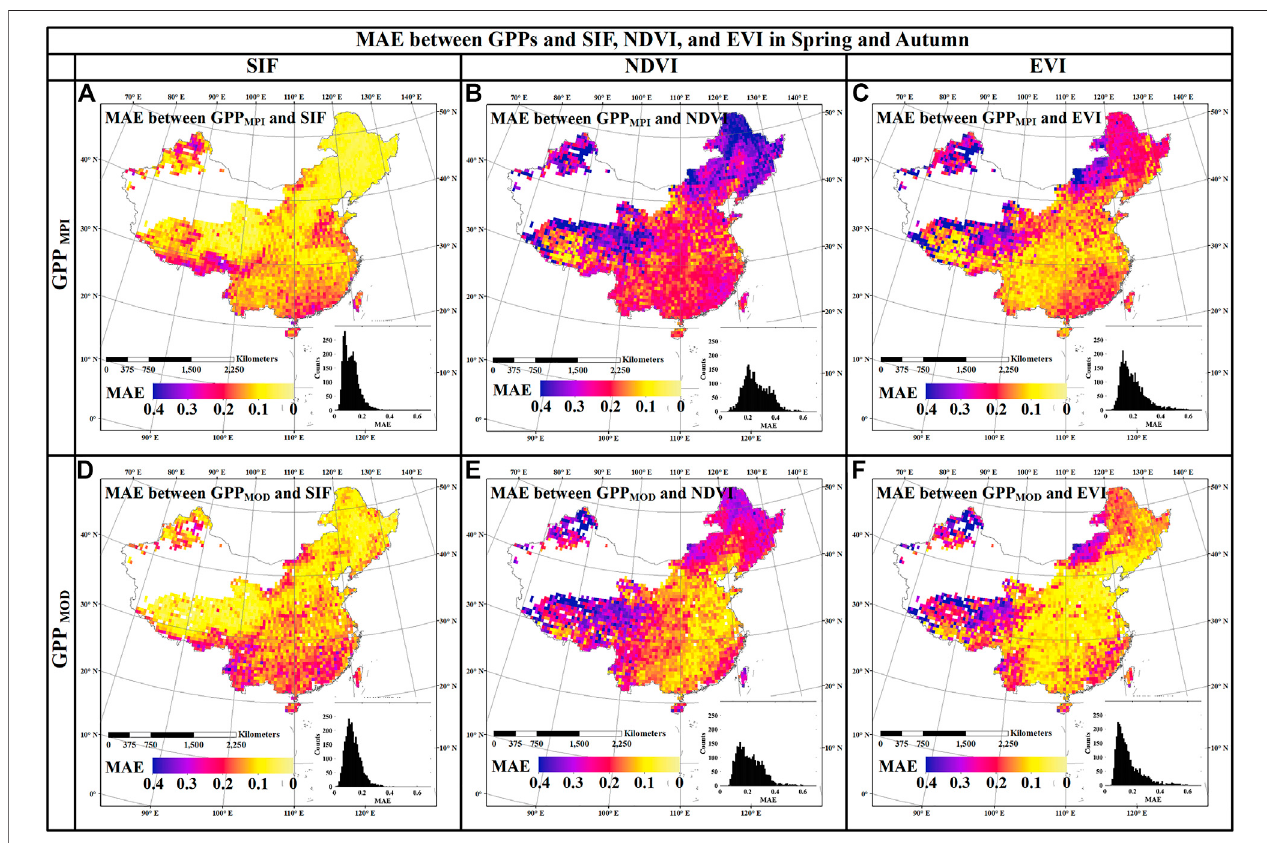
FIGURE3| SpatialdistributionsofMAEbetweenGPPsandSIF[ (A) forGPP MPI and (D) forGPP MOD ],GPPsandNDVI[ (B) forGPP MPI and (E) forGPP MOD ],aswell as GPPs and EVI [ (C) for GPP MPI and (F) for GPP MOD ] in China during 2007 – 2013.